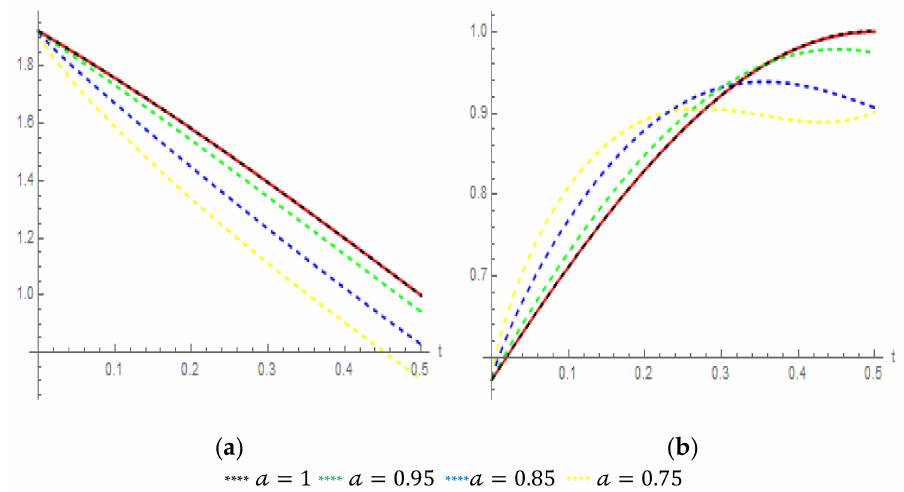
Figure 4. ( a ) 2D-Plots of exact solutions U ( 𝓍 , 𝓉 ), and the 7-th approximate solutions U 7 ( 𝓍 , 𝓉 ) and V ∈ [0, 0.5], and 𝓍 = 1, at various values of 𝒶 . ( b ) 2D-Plots of exact 7 ( 𝓍 , 𝓉 ), for system (7), with 𝓉 solutions V ( 𝓍 , 𝓉 ), and the 7-th approximate solutions V 7 ( 𝓍 , 𝓉 ), for system (7), with 𝓉 ∈ [0, 0.5], and 𝓍 = 1, at various values of 𝒶 .